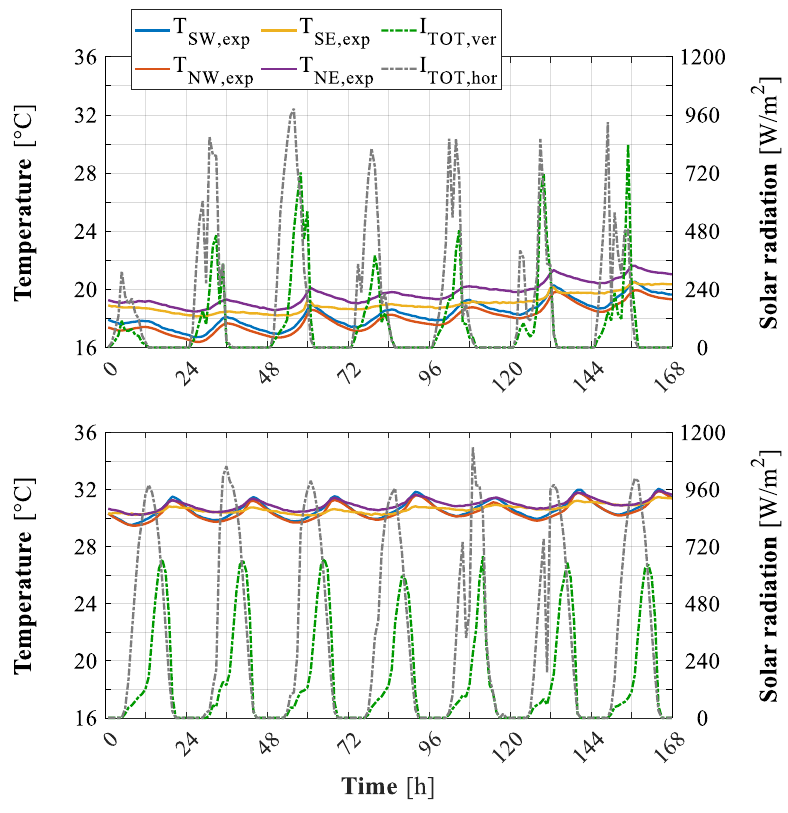
Figure 11. Time histories of the internal surface temperatures of the South-West, North-West, South-East, North-East walls and of the solar radiation incident on the vertical façade and on the horizontal roof — Sample winter week: March 23rd – 29th ( top ) and sample summer one: July 1st – 7th ( bottom ).